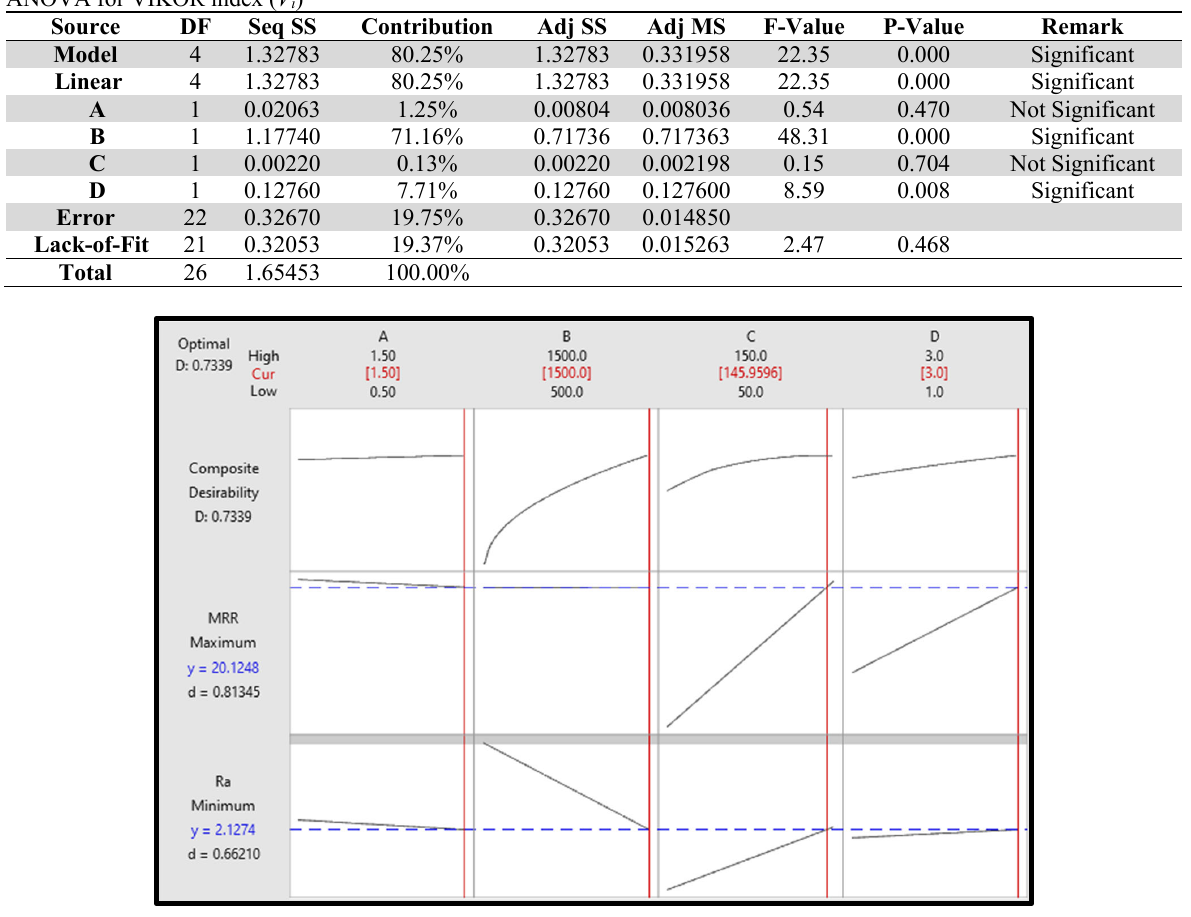
Fig.10. Optimal setting by Box-Behnken